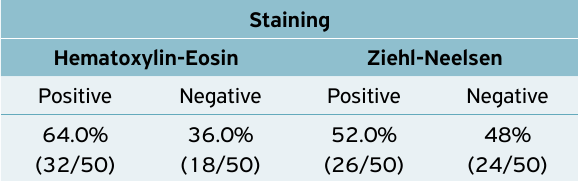
Table 2. Histopathological diagnosis of lymph nodes with tuberculosis‑like lesions from cattle slaughtered in an abattoir under federal